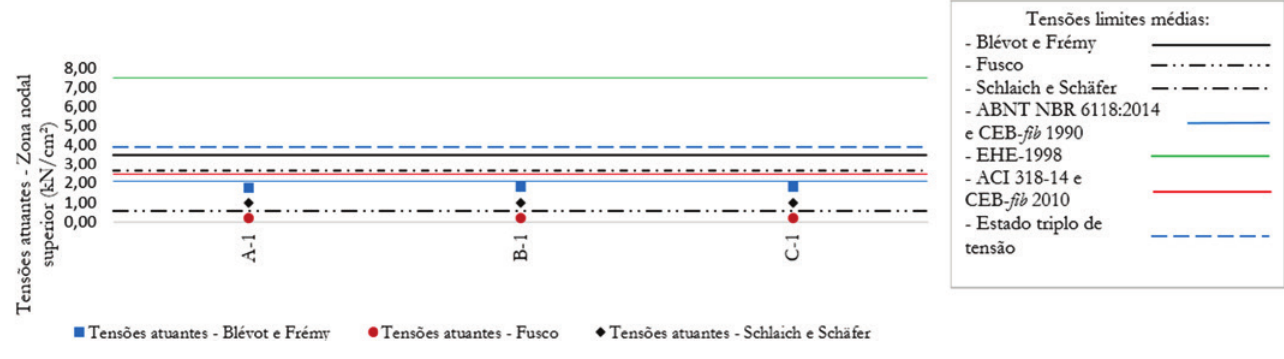
Modelos ensaiados por Fusco [6] × σ